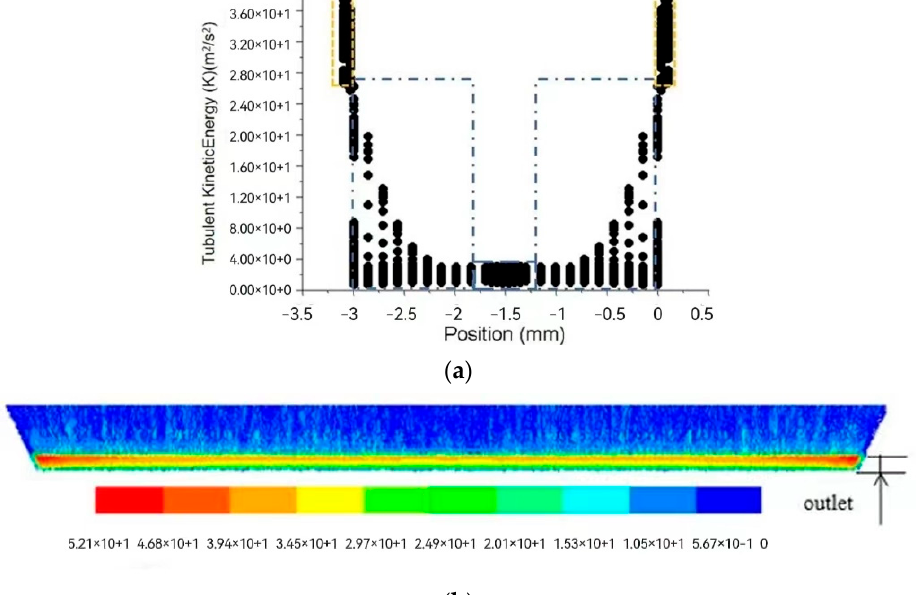
Figure 7. ( a ) Scatter diagram of Turbulent kinetic energy along Z axis of screen.( b ) Contour of particle velocity at screen outlet.